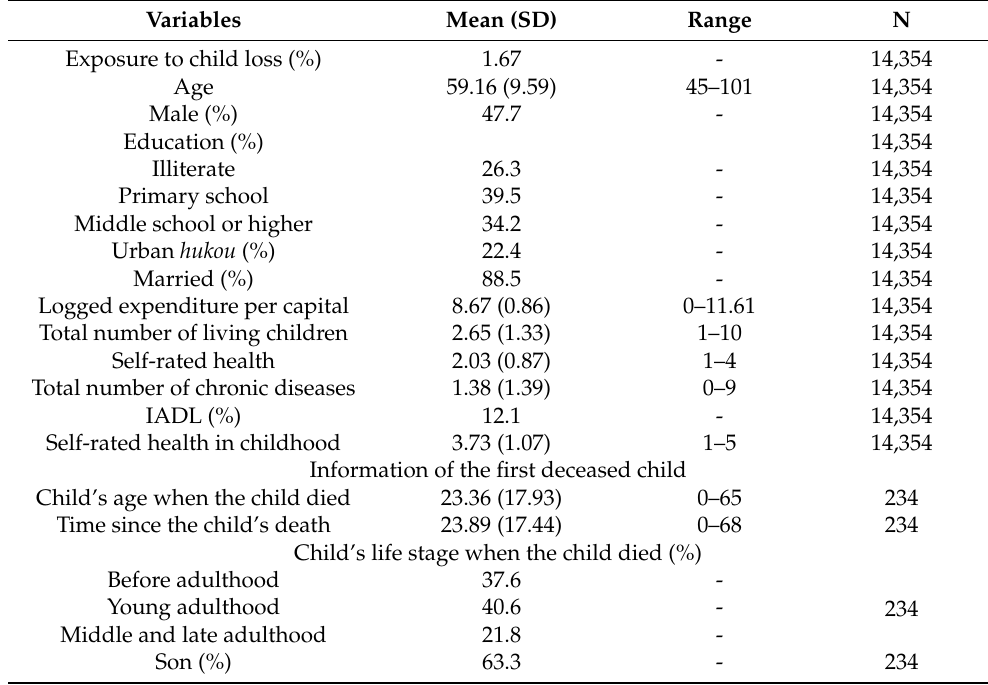
Table 1. Statistics of analytic sample in wave 1.